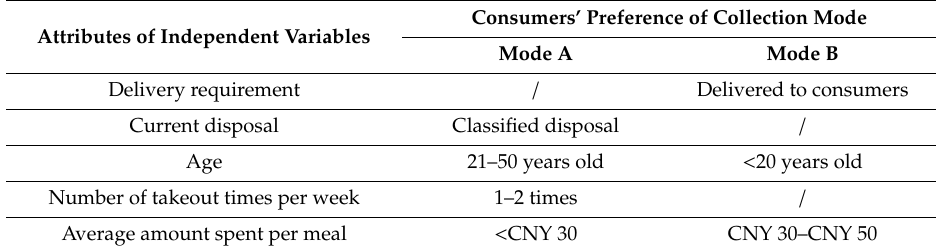
Table 7. Relationship between the attributes of independent variables and the consumers’ preferences.